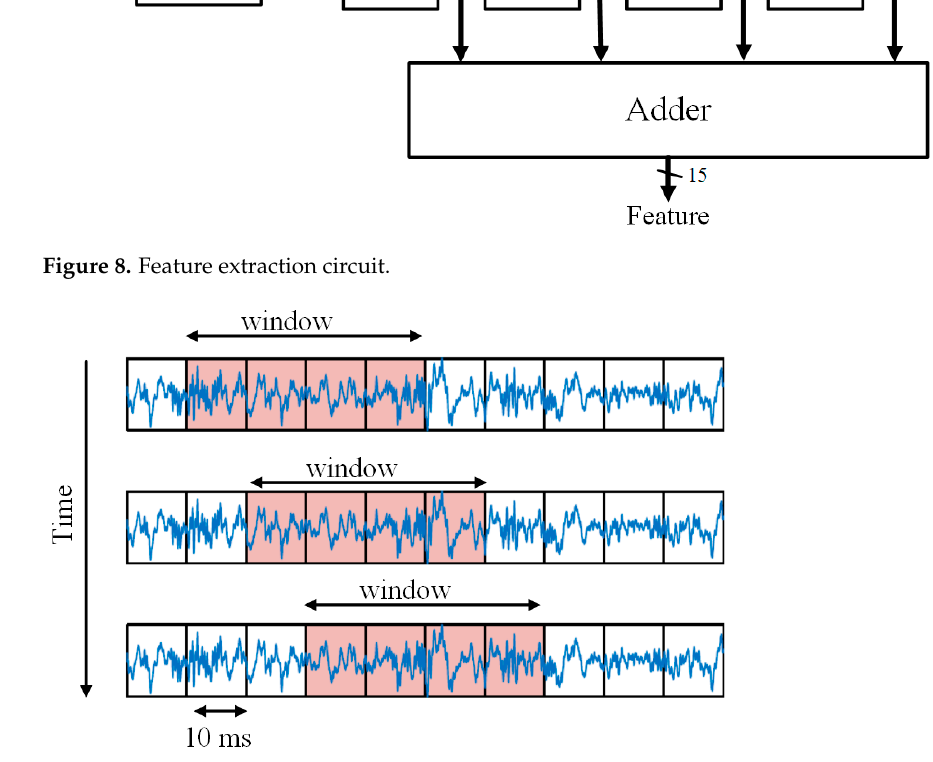
Figure 9. A 40 ms moving window with 30 ms overlap.